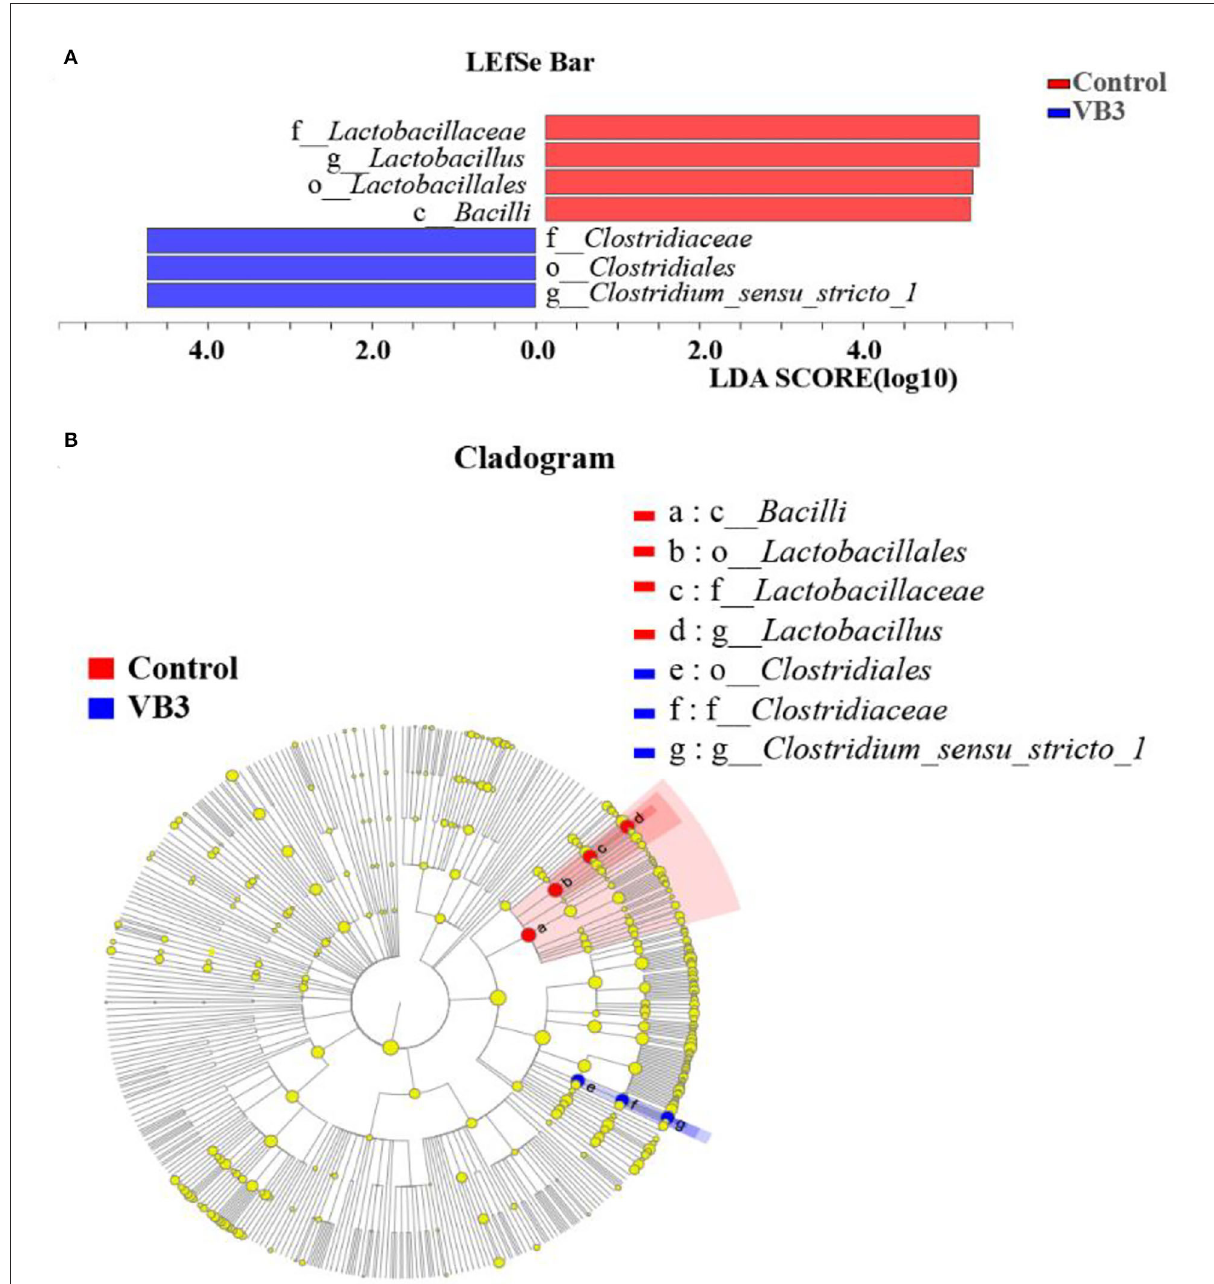
FIGURE3 LEfSe analysis between the experimental group (VB3) and control group (Control). Red, control group. Blue, experimental group. (A) Histogram of the results of LEfSe between the experimental and control groups and their respective effect sizes; P -value < 0.05 considered significant. (B) Cladogram showing taxonomic representation of differences between the experimental and control